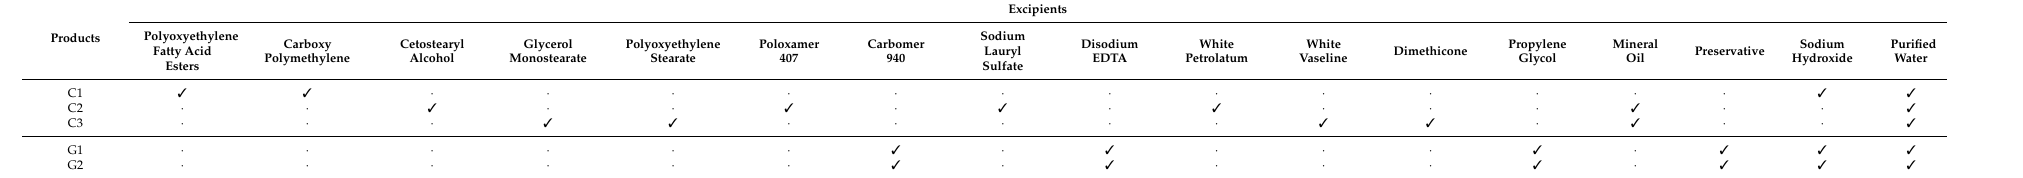
Table 1. Excipients present in commercial topical creams (C1, C2, and C3) and gels (G1 and